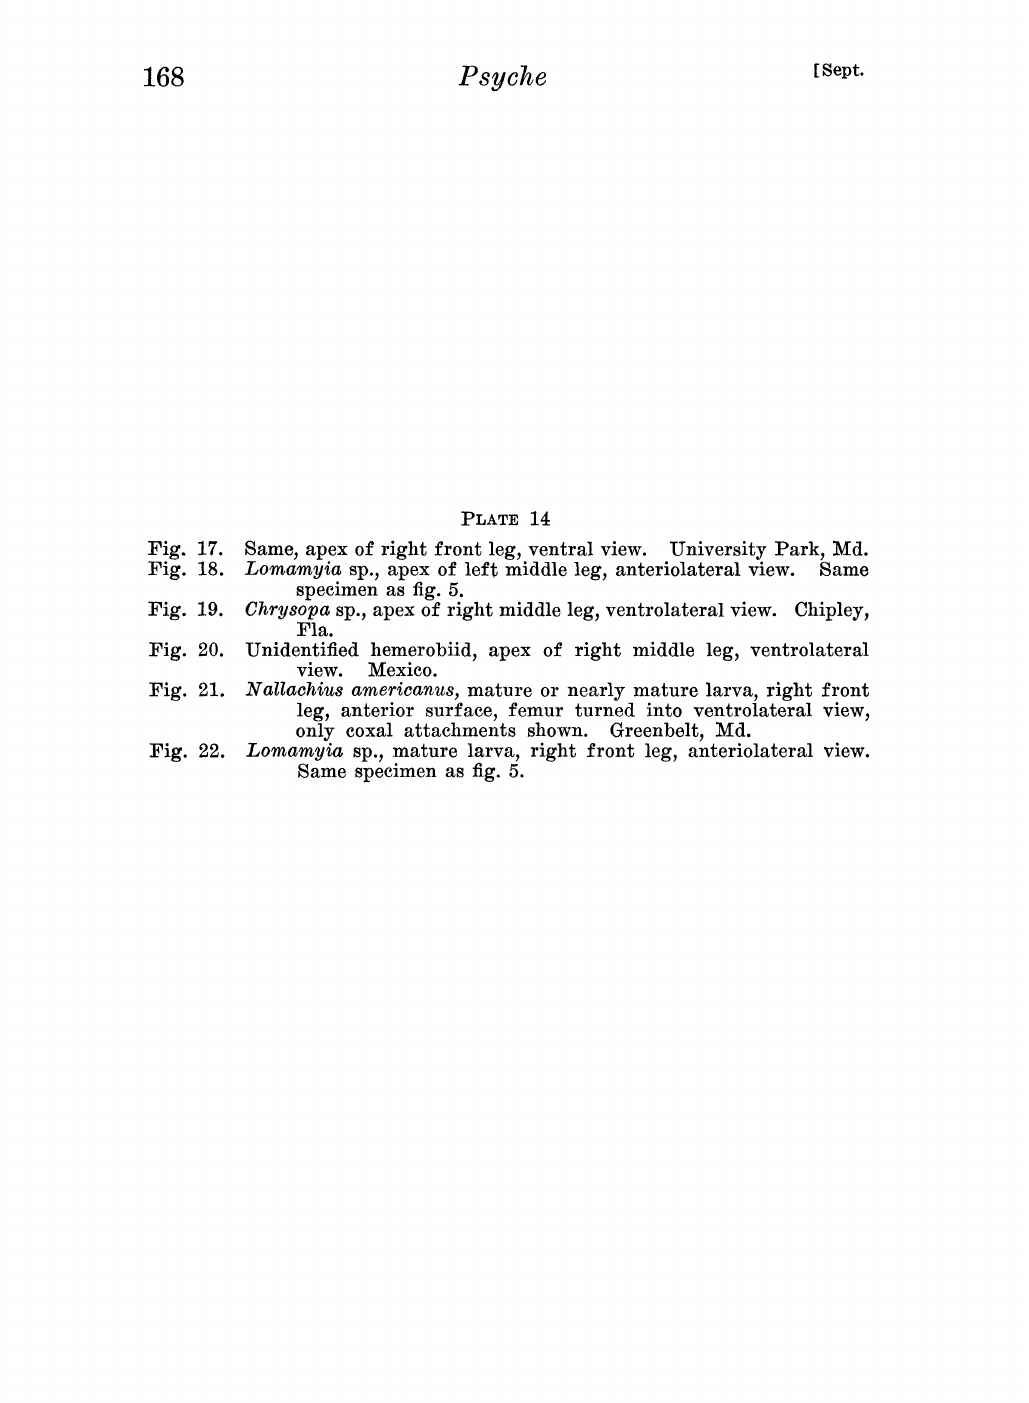
PLATE 14 Same, apex of right front leg, ventral view. University Park, Md. Lomamyia sp., apex of left middle leg, anteriolateral view. Same specimen as fig. 5. Chrysopa sp., apex of right middle leg, ventrolateral view. Chipley, Fla. Unidentified hemerobiid, apex of right middle leg, ventrolateral view. Mexico. Nallachius americanus, mature or nearly mature larva, right front leg, anterior surface, femur turned into ventrolateral view, only coxal attachments shown. Greenbelt, Md. Lomamyia sp., mature larva, right front leg, anteriolateral view. Same specimen as fig.